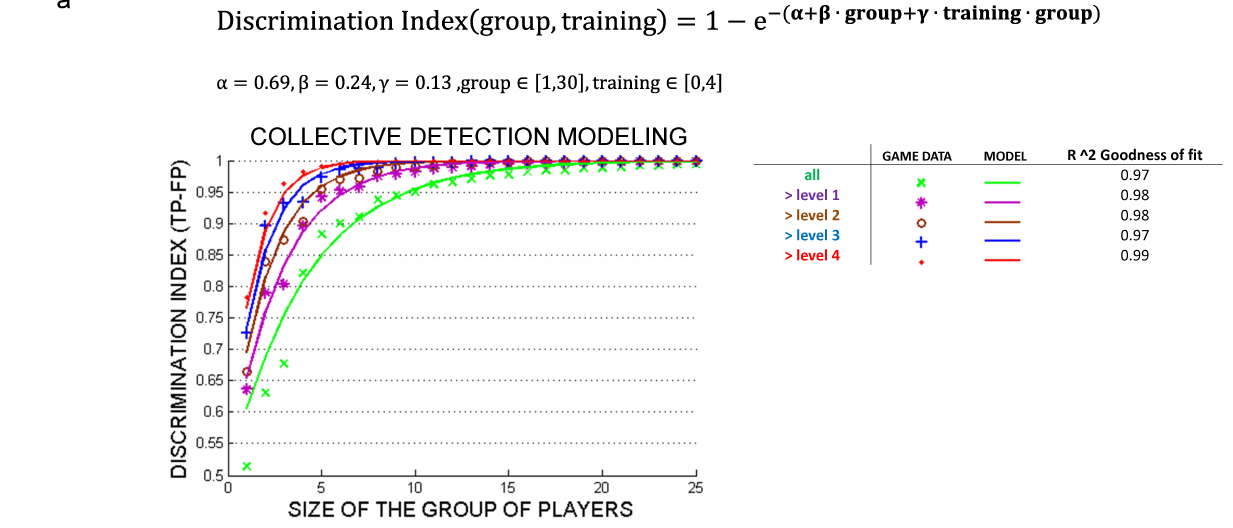
Figure 6. Model of the collective detection of malaria parasites. Curve fitting of the mean accuracy rate for all group sizes and training